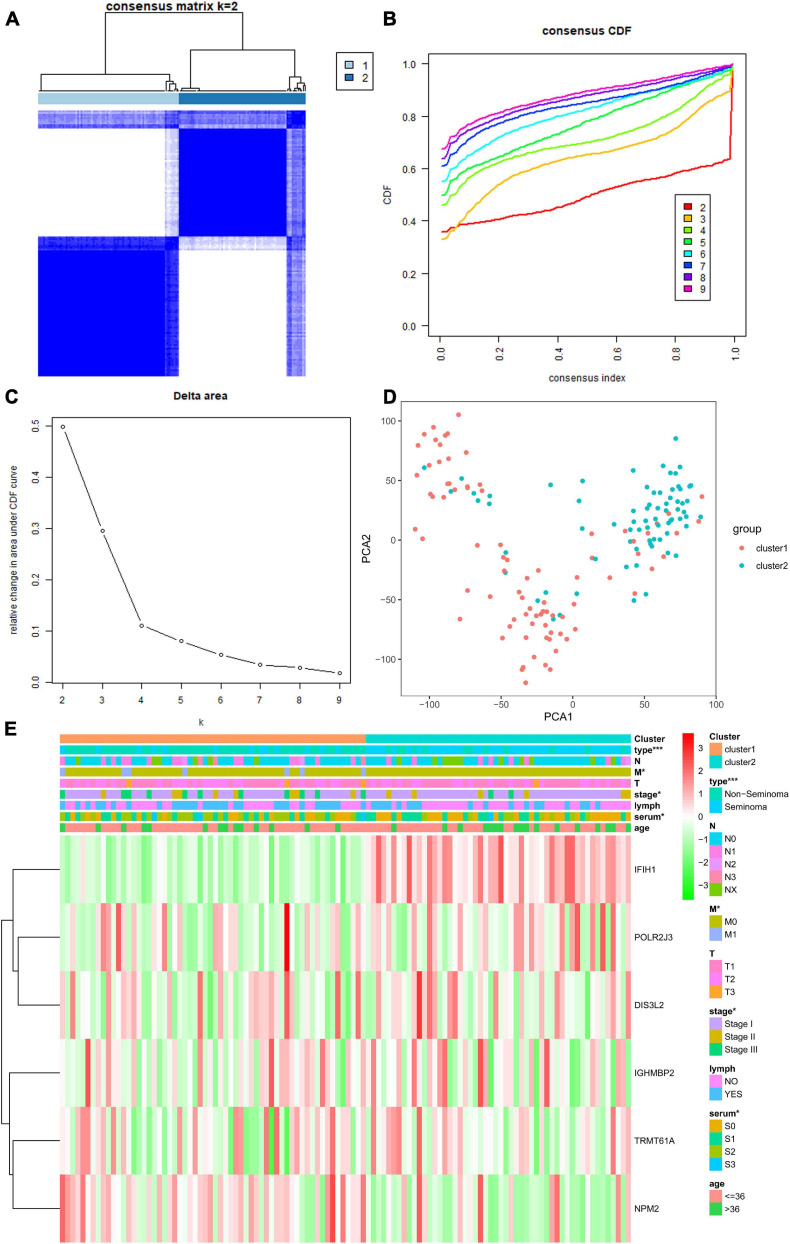
Differential clinical characteristics of TGCT patients in the two different clusters. (A) Based on the expression similarity of RBPs, the TCGA TGCT cohort was separated into two distinct clusters when k = 2. (B,C) Consensus CDF and relative change in area under CDF curve for k = 2–9. (D) Principal component analysis based on two clusters. (E) Significant difference was observed for the type, grade, stage, and serum marker study levels between cluster 1 and cluster 2. CDF, clustering cumulative distribution function. *p < 0.05, **p < 0.01, and ***p < 0.001 compared with the cluster2 group. TGCT, Testicular germ cell tumors; RBPs, RNA-binding proteins; TCGA, The Cancer Genome Atlas.